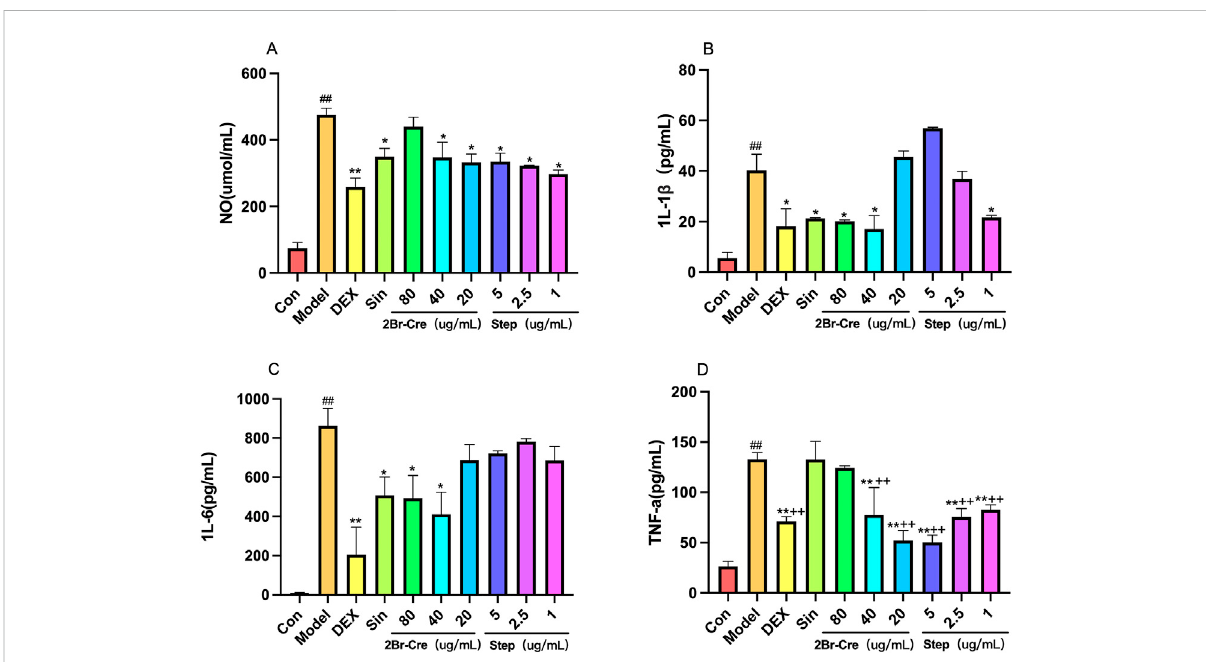
FIGURE 6 In vitro cell experiment results for 2Br-Cre and Step. The effects of 2Br-Cre (80, 40, and 20 μ g/ml) and Step (5, 2.5, and 1 μ g/ml) on proin fl ammatory cytokine release [TNF- α (D) , IL-1 β (B) , and IL-6 (C) ] and on nitric oxide (A) release by the RAW264.7 cells, Data are expressed as mean±SD,( n =3).* p < 0.05,** p < 0.01,versusModelgroup. ## p < 0.01versusCongroup. ++ p < 0.01versusSingroupusingone-wayANOVAfollowed by S-N-K ’ s post hoc multiple-comparison